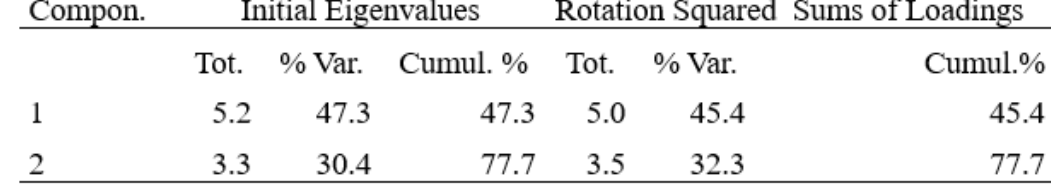
Extraction Method: Principal Component